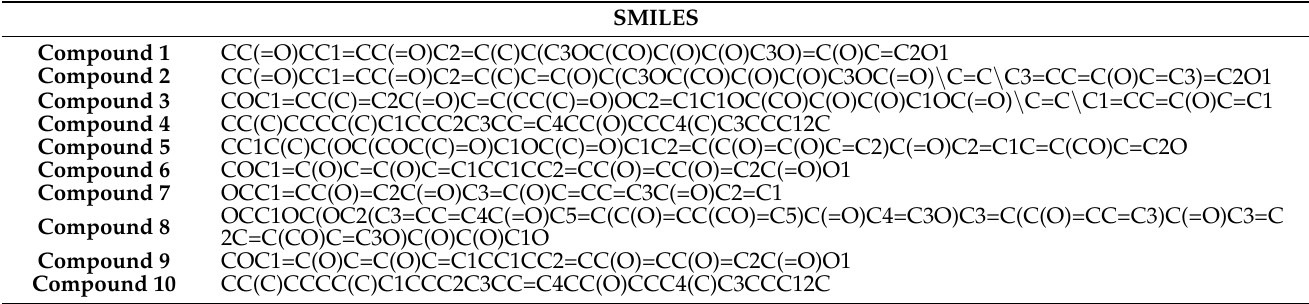
Table 7. The generated SMILES for the active constituents in Aloe perryi extract.